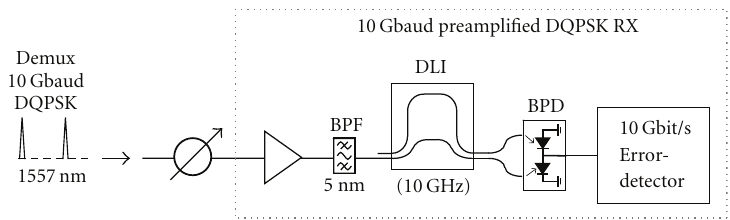
Figure 13: 5.1 Tbit/s demodulator receiver with a preamplifier, a delay interferometer, and a balanced detector.